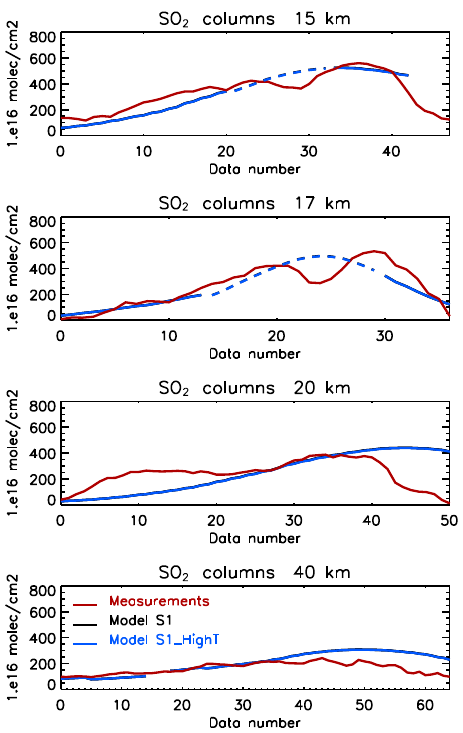
Figure 4. Comparison between BrO columns observed by Bani et al. (2009) (red line) and simulated by the model for S1 (black line) and S1_HighT (blue line). See Fig. 3 for details on the method of comparison. Reported error (1 σ) is 1.22 × 10 14 molec cm − 2